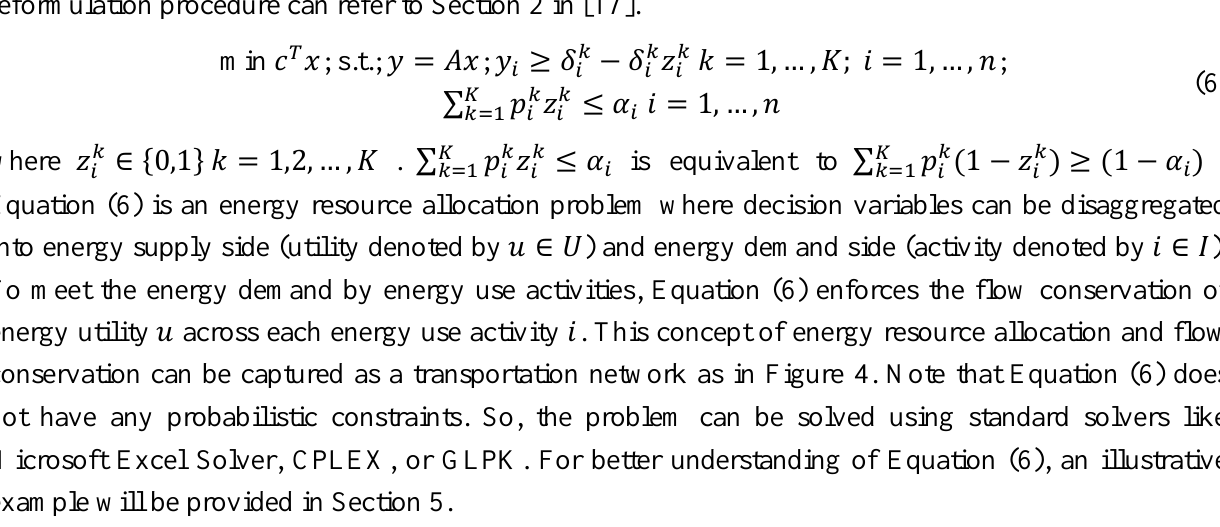
Figure 4. General energy demand and supply model with uncertainty in